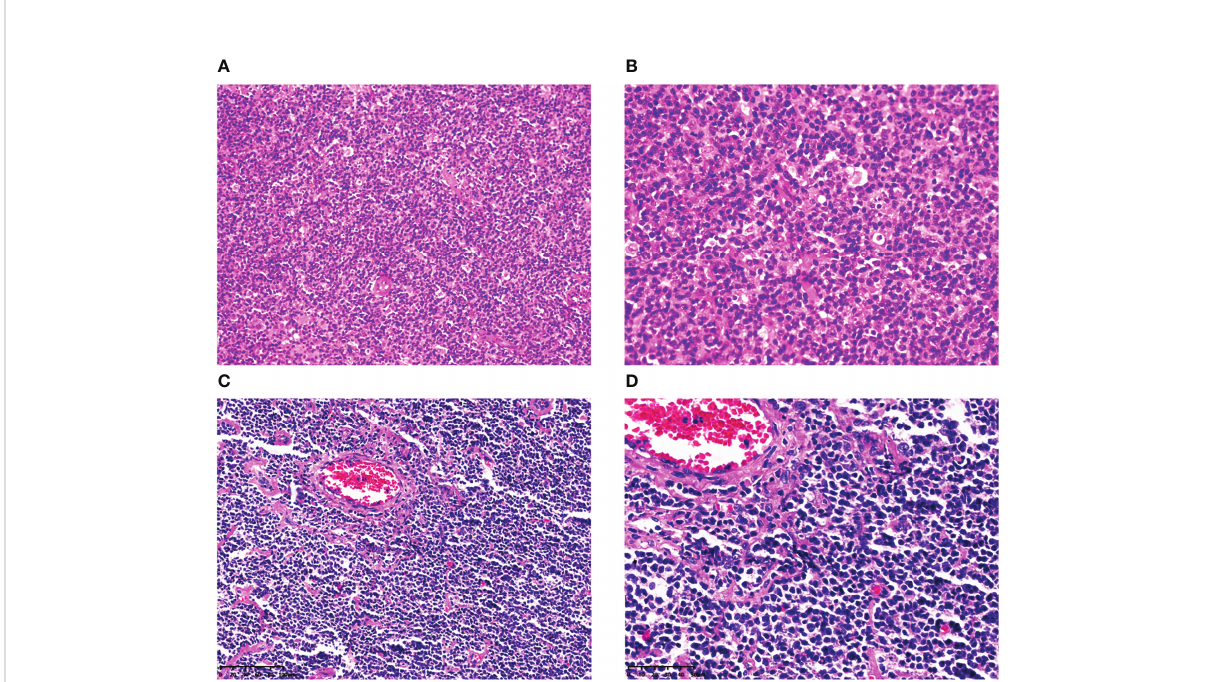
FIGURE 1 Histopathological features of MCL with EBER positivity. In case 1, at low magni fi cation (×200), the tumor cells were small-to-medium-sized lymphocytes, and the cell morphology was single (A) . At high magni fi cation (×400), the tumor nucleus was slightly irregular, similar to the central cells, the nucleolus was not obvious, mitosis was rare, and tissue-like cells were observed in the tumor background; however, HRS-like cells were not found (B) . In case 4, at low magni fi cation (×200), the tumor cells were small-to medium-sized lymphocytes, with scattered vitreous degeneration of blood vessels (C) . At high magni fi cation (×400), the nucleus of the tumor was slightly irregular, similar to the central cells, the nucleolus was not obvious, mitosis was rare, and there were no HRS-like cells in the background (D) .